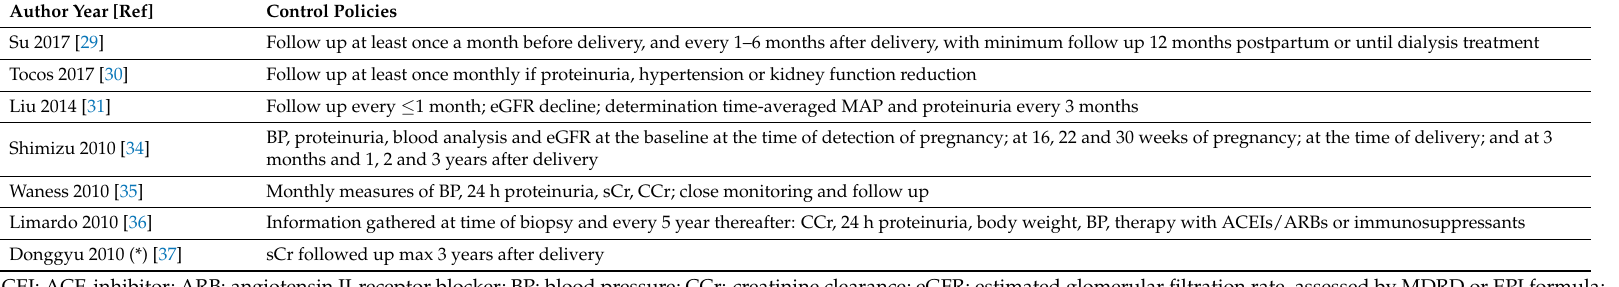
Table 2. IgA nephropathy: maternal and fetal control policies, in the papers reporting on them (Case Series).